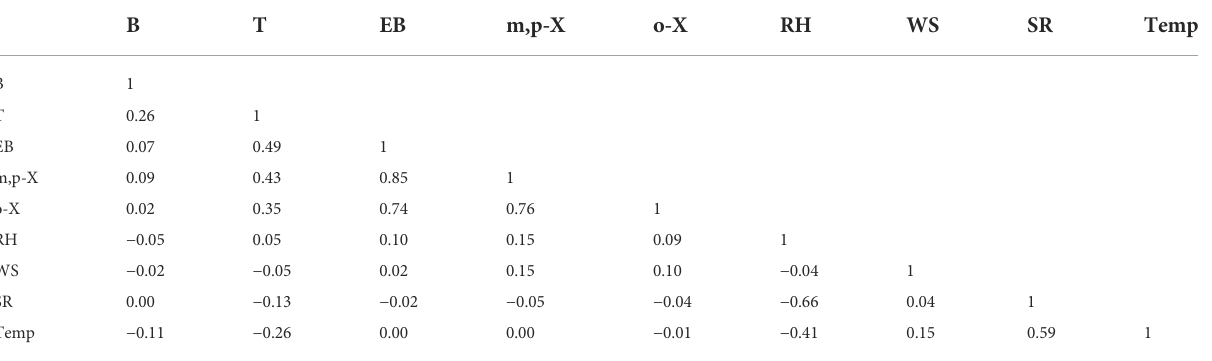
TABLE 3 Correlation matrix of BTEX concentrations with meteorological